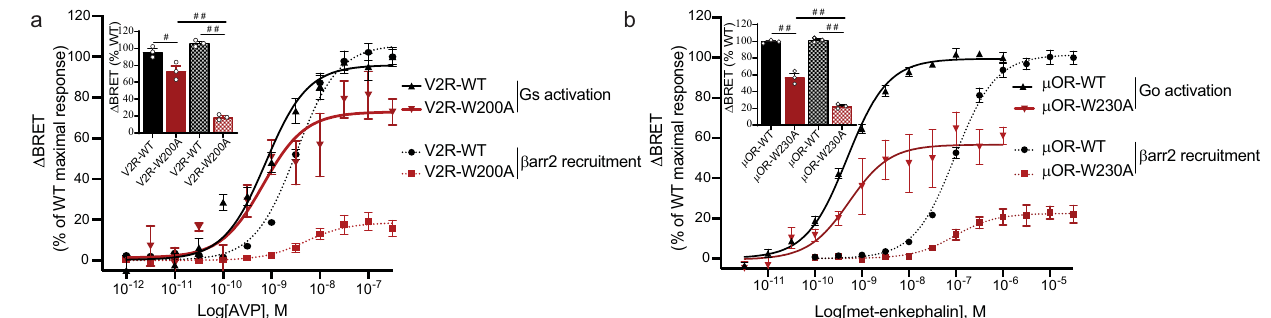
Fig. 6 | W5.34/33 is a common biased signaling switch in dimerizing peptide- bindingGPCRs. a , b Ligand-promotedGs(V2R)orGo ( μ OR)and β arr2recruitment to the membrane in the presence of V2R-WT or V2R-W200 5.33 A ( a ), and μ OR-WT or μ OR-W230 5.34 A ( b ). Gs and Go activation were detected by monitoring the dis- sociationbetweenG α andG βγ byBRETwhereas β -arrestinrecruitmenttotheplasma membrane was assessed in cells transfected with rGFP-CAAX, WT, or mutant